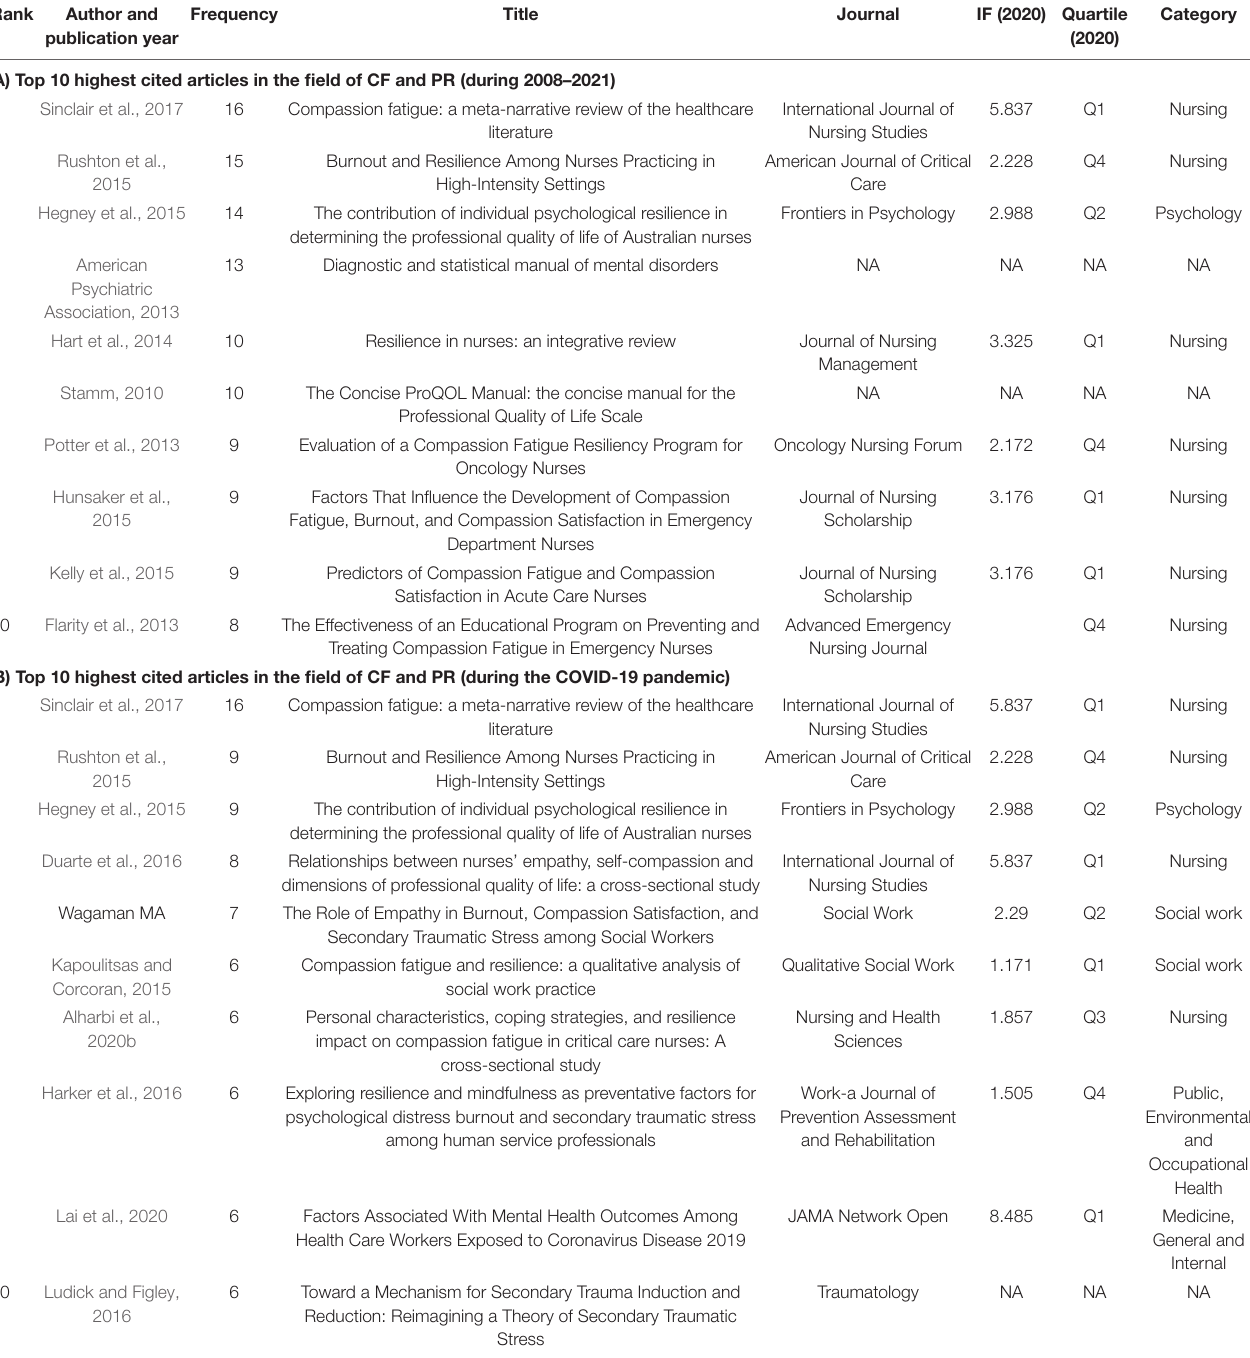
TABLE 2 | Main clusters ( > 15 members) of reference co-citation analysis in the field of CF and